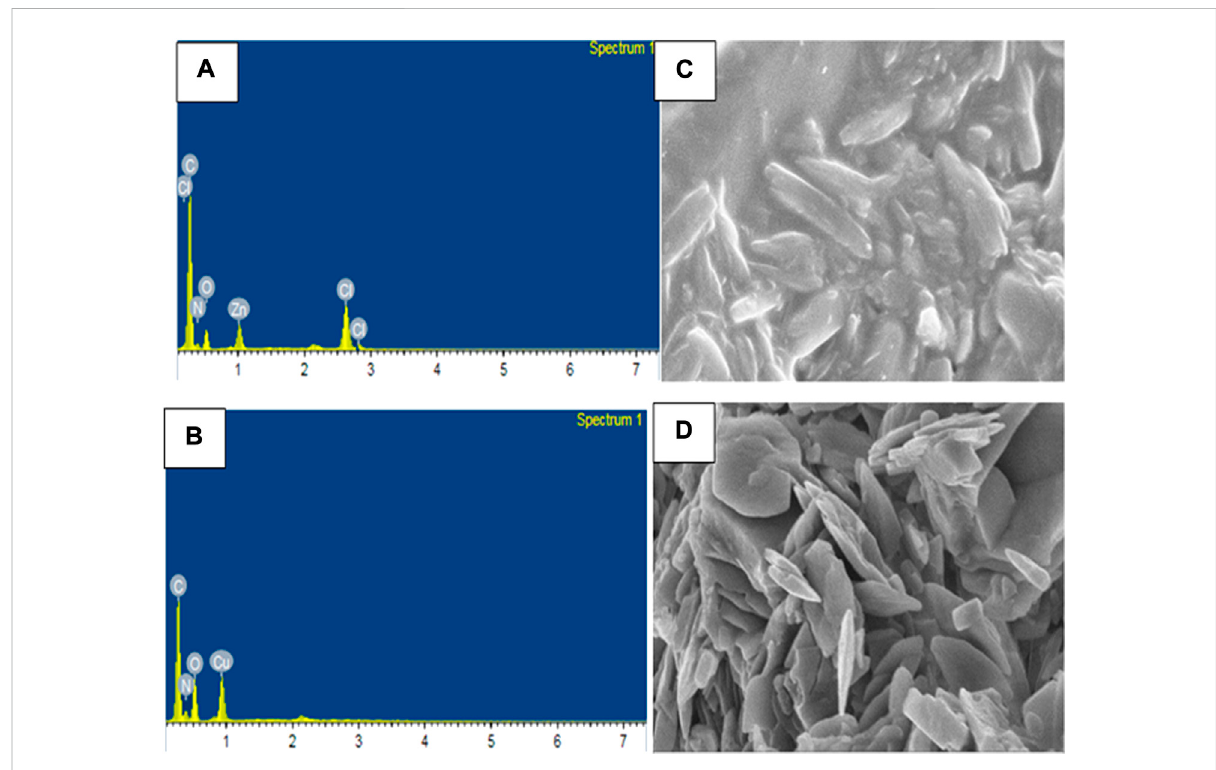
FIGURE 4 EDX of (A) Zn(II) and (B) Cu(II), and SEM image of (C) Zn(II) and (D) Cu(II)